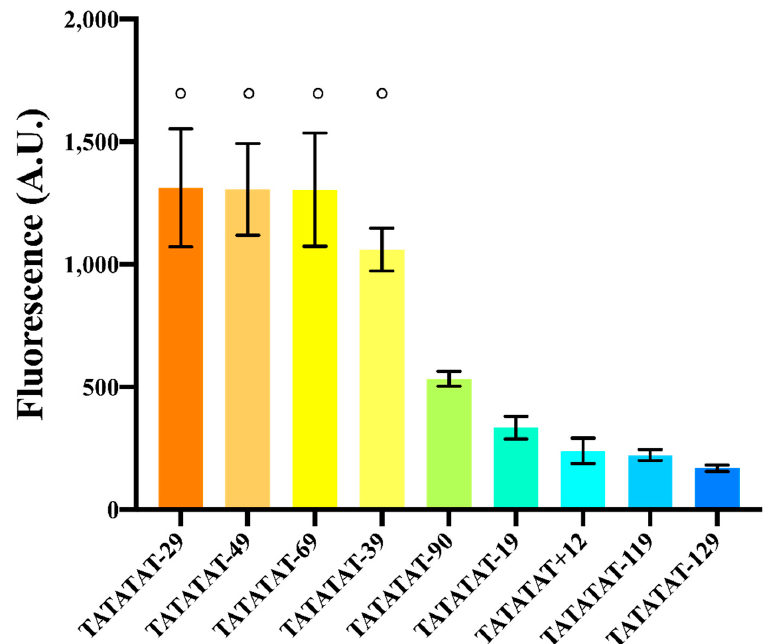
Figure 4. Effects on fluorescence expression due to the distance between the TATA box and the TSS. Experiments were carried out (in three different days) on variants of pSV40*(TATATAT). The symbol ˚ on top of different columns indicates that there is no significant statistical difference among the fluorescence levels of the corresponding promoters ( p -value = 0.3704, one-way